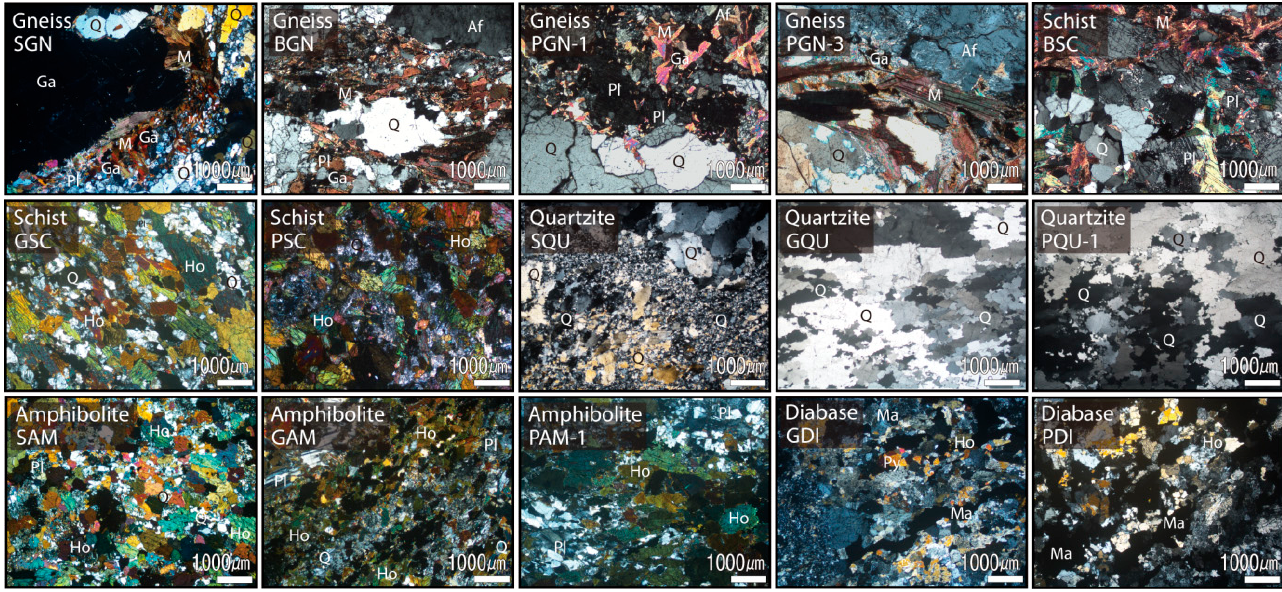
Figure 6. Photomicrographs showing rock textures and component minerals. Samples are as pre- sented in Table 1. Af; alkali feldspar, Ch; chlorite, Ga; garnet, Ho; hornblende, M; mica, Ma; magnetite, Pl; plagioclase, Py; pyroxene, Q; quartz.